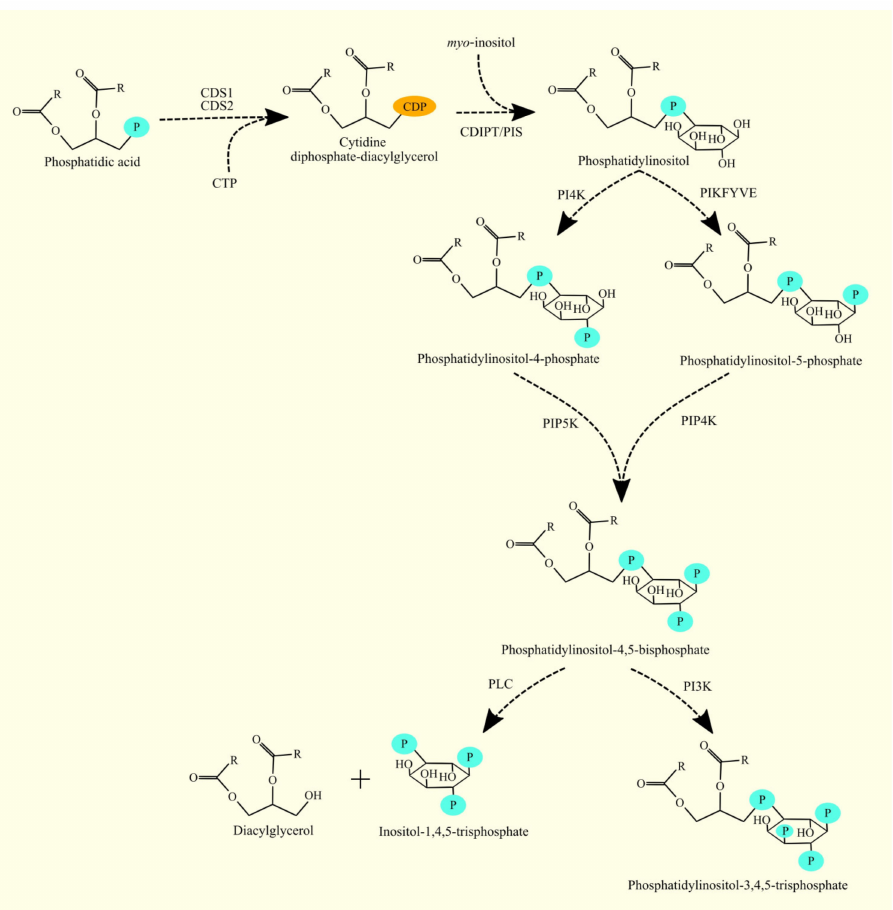
Figure 9. Synthesis of PI. Phosphatidic acid is converted to CDP-DAG. In the endoplasmic retic- ulum, this reaction is catalyzed by CDS1 and CDS2. In the endoplasmic reticulum, CDP-DAG is converted to PI by CDIPT/PIS, after which this glycerophospholipid is phosphorylated on the inositol ring by PIKFYVE and PI4K, resulting in the formation of phosphatidylinositol-5-phosphate and phosphatidylinositol-4-phosphate, respectively. These glycerophospholipids are then further phosphorylated by PIP4K and PIP5K, producing PIP 2 , which plays a role in intracellular signal transduction. It can be further phosphorylated by phosphatidylinositol-4,5-bisphosphate 3-kinase (PI3K) to phosphatidylinositol-3,4,5-trisphosphate (PIP 3 ). PIP 2 can also be converted to DAG and inositol-1,4,5-trisphosphate (IP 3 ) by phospholipase C